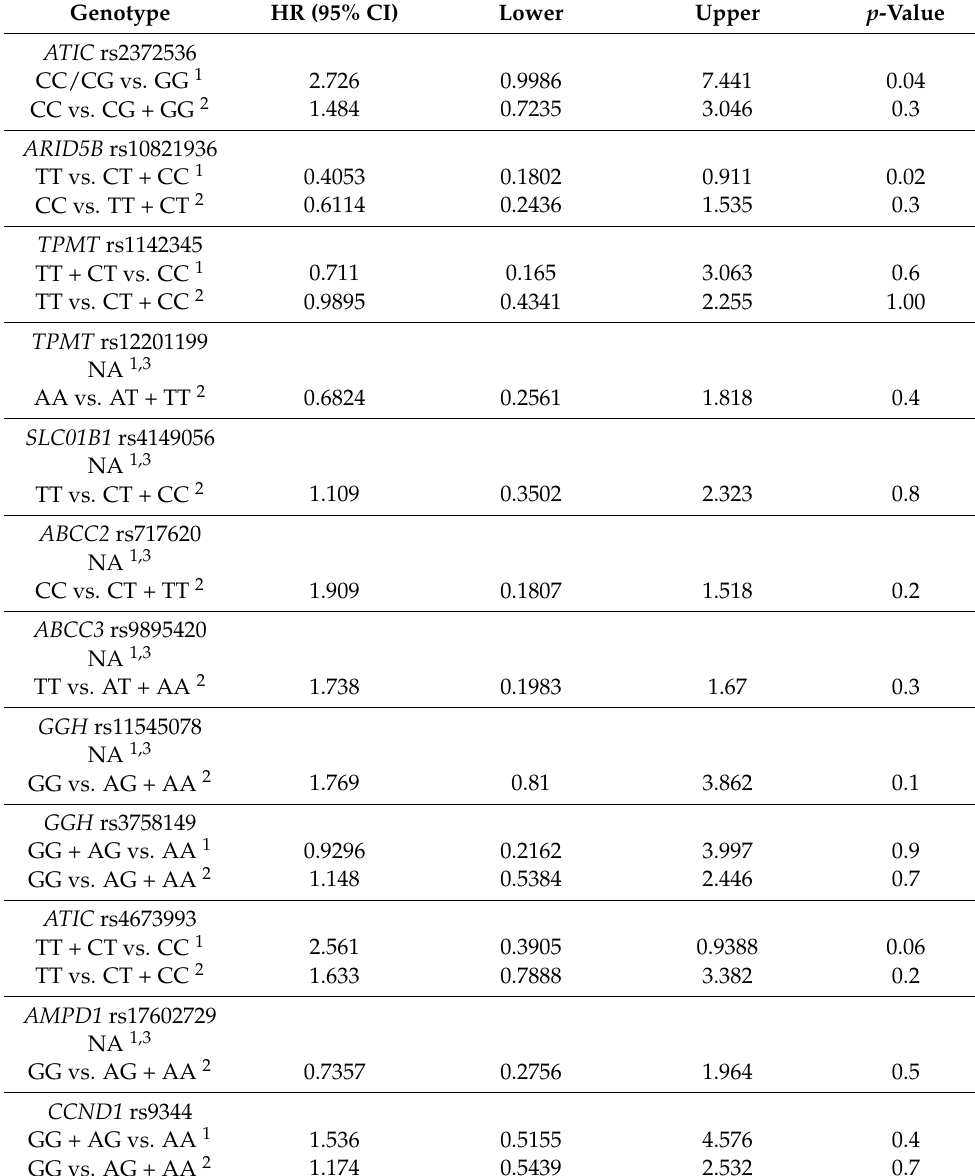
Table 2. Hazard ratio analysis of the genotypes analyzed with the time of treatment